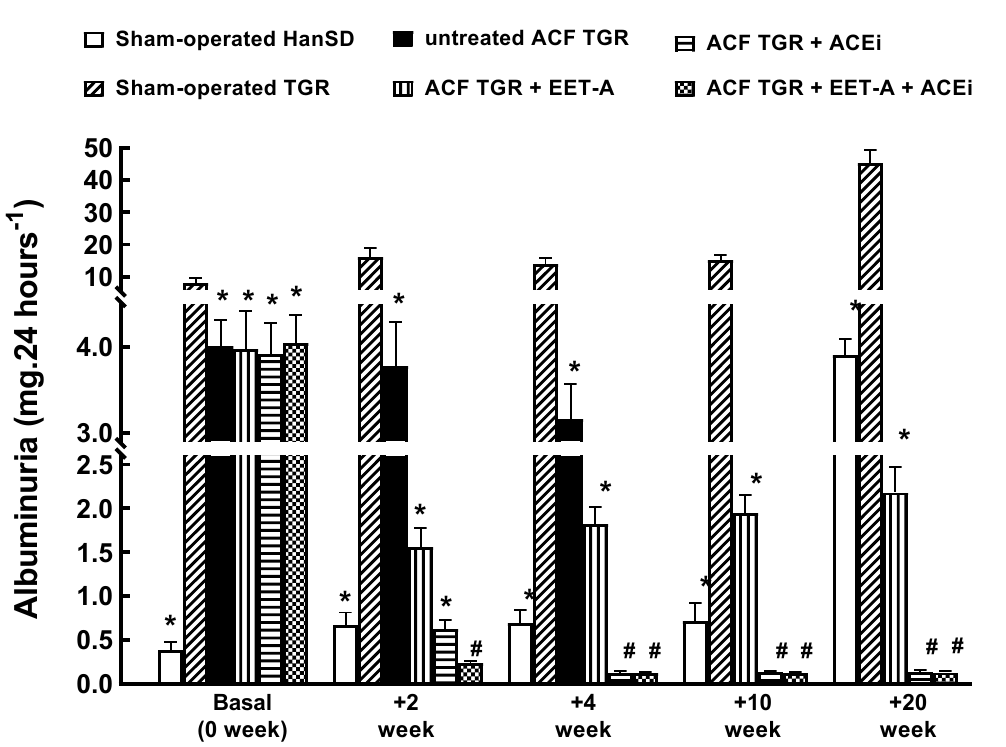
Figure 3. Assessment of the effects of treatment on albuminuria. Albuminuria in sham-operated transgene-negative Hannover Sprague-Dawley (HanSD), sham-operated heterozygous Ren-2 transgenic rats (TGR), and TGR rats with aorto-caval fistula (ACF) two weeks after the creation of ACF or sham-operation, treated either with angiotensin-converting enzyme inhibitor (ACEi) alone or with 14,15-epoxyeicosatrienoic acid analog (EET-A) alone or with the combination of EET-A and ACEi. * p < 0.05 versus sham-operated TGR. # p < 0.05 versus sham-operated HanSD rats.